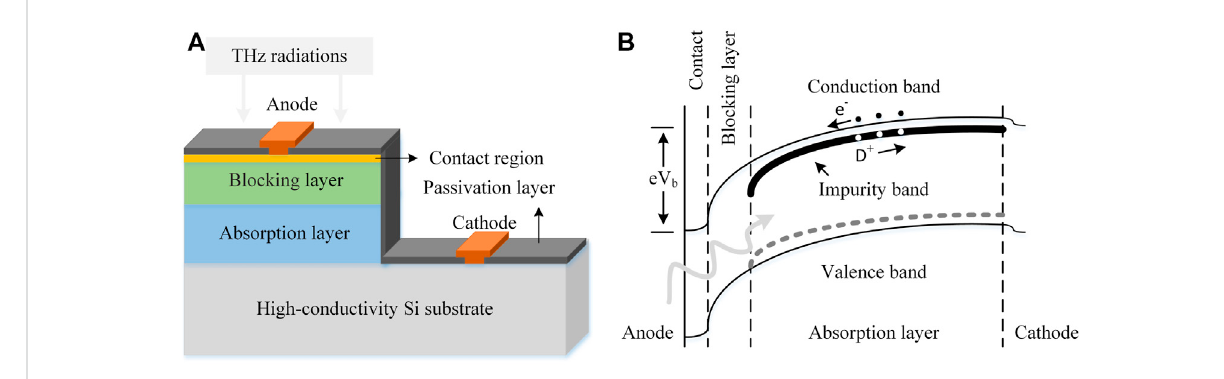
FIGURE 2 (A) The diagram of Si-based BIB detector. (B) The band gap structure of silicon-based BIB detector.